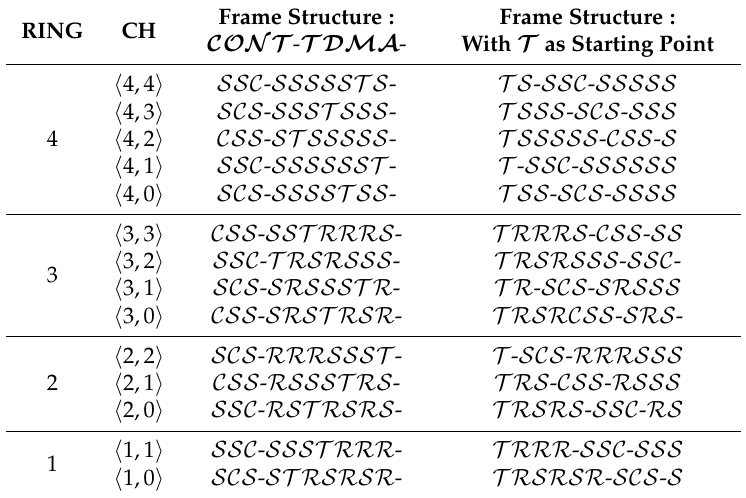
Table 6. Frame structure for nodes in A 0 ∪ S 0 ∪ A 1 . ( N Intra , N Inter ) = ( 3,7 ) and Ring ≤